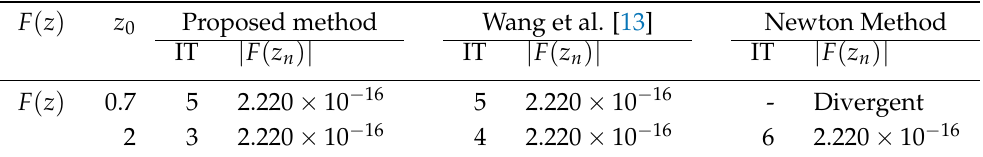
Figure 1. Basin of attraction for function F ( z ) = 10 z exp ( − z 2 ) − 1 by different methods. Table 1. Comparison of methods for F ( z ) = 10 z exp ( − z 2 ) − 1, z ∗ = 1.67963061042845 “IT” is the number of